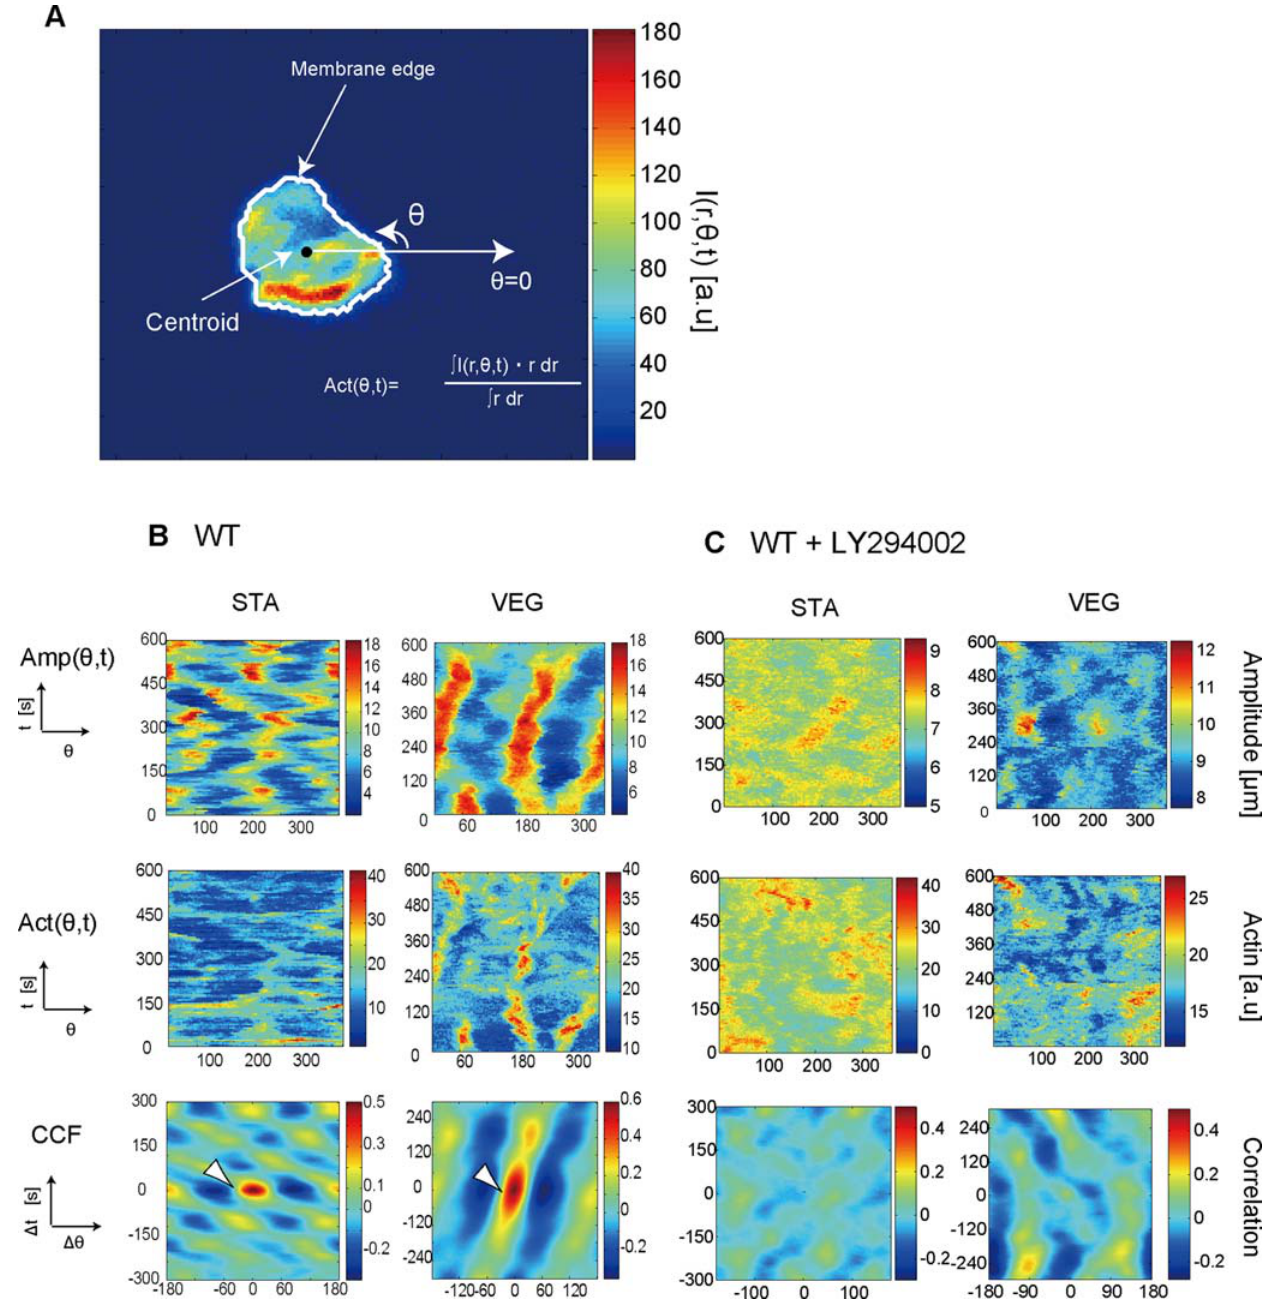
Figure 5. F-actin accumulation correlates with membrane elongation. (A) Summary of the analysis of F-actin accumulation. Scale bar is 20 m m. (B) and (C): Amp ( h ,t ), Act ( h ,t ) and the cross-correlation function (CCF) C Act,Amp ( D h , D t ) between Amp ( h ,t ) and Act ( h ,t ) for the WT cells in both VEG and STA (B) and for the WT + LY294002 cells in both VEG and STA (C). White arrowhead in CCF of WT cells indicates the high degree of correlation between the dynamics of F-actin accumulation and the dynamics of cell